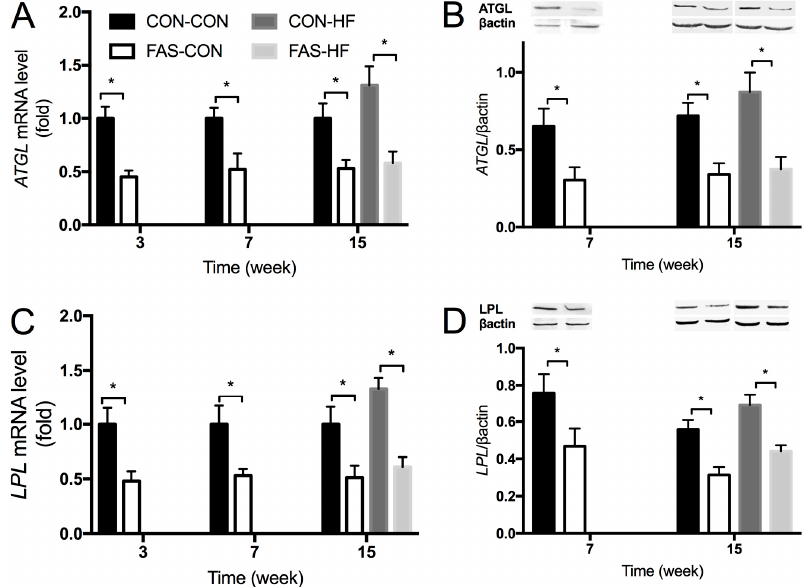
Figure 4. The hepatic: ATGL mRNA ( A ); and protein ( B ) levels; and white adipose LPL mRNA ( C ); and protein ( D ) levels in the male offspring at different time points. Representative Western blot photographs are shown ( B , D ). Values are means with standard deviations ( n = 10). * The difference between the two groups indicated by the line segment is significant, p < 0.05.